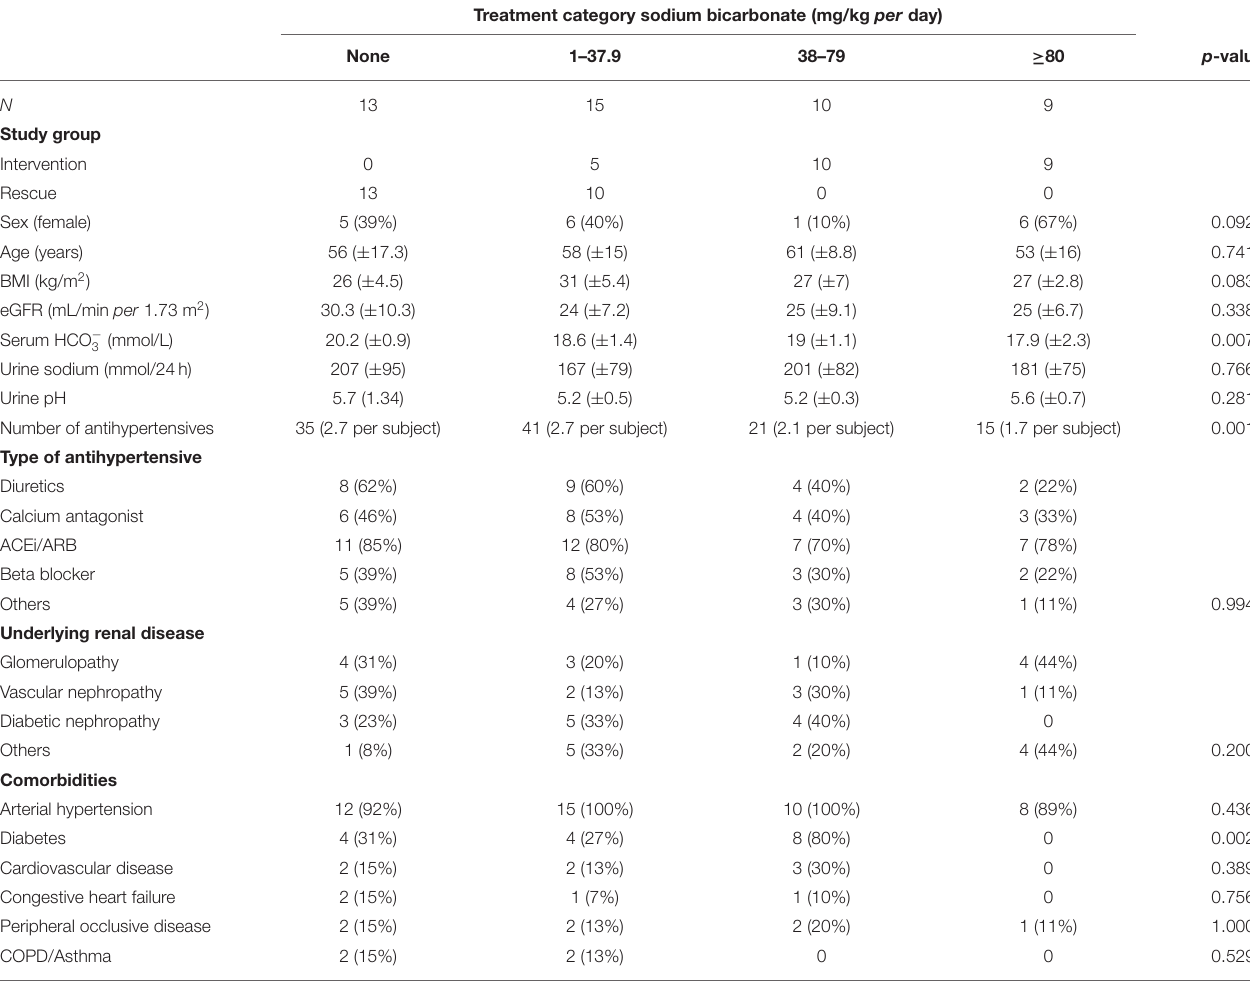
TABLE 1B | Basic demographic data at baseline [count (percent), mean (standard deviation)] with respect to treatment